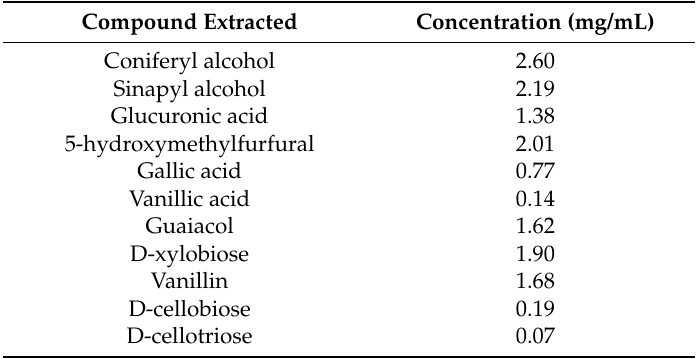
Table 1. The products extracted from bamboo powder using boiling and ultrasonic probe treatments and analyzed by LC-ESI-TOF